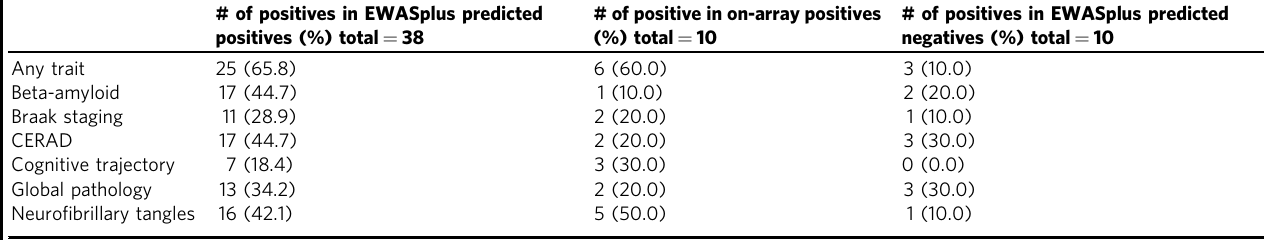
# of positive in on-array positives # of positives in EWASplus predicted (%) total = 10 negatives (%) total = 10